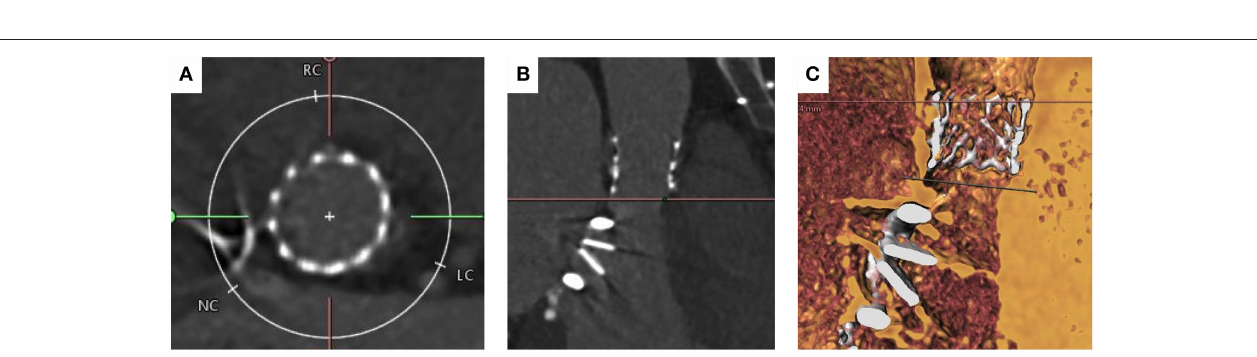
FIGURE 6 | Implantation of SAPIEN 3 in patient with bicuspid aortic valve with previous mitral valve replacement. (A) Aortogram for root alignment with pigtail catheter in the right coronary cusp. (B) Balloon sizing with 20mm balloon touching hinge points with simultaneous aortogram showing filling of coronary arteries. (C) Successful deployment of 23mm SAPIEN 3 valve with no paravalvular leakage.